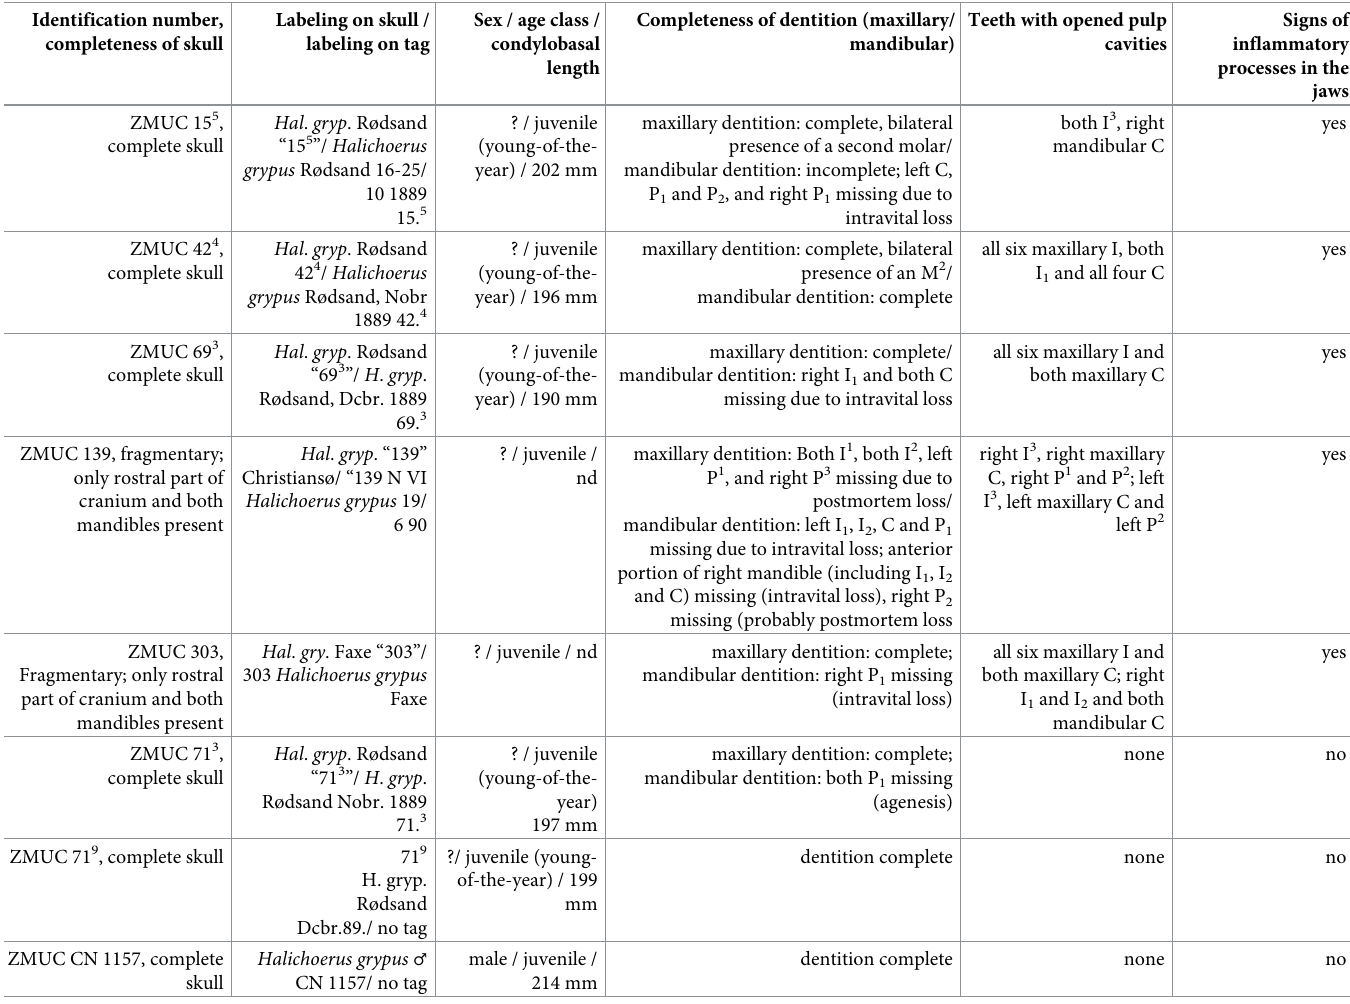
Table 1. List of Baltic grey seals ( Halichoerus grypus grypus ) skulls from the collection of the Natural History Museum of Denmark, University of Copenhagen (ZMUC) analyzed in the present study. All teeth present in the specimens belonged to the permanent dentition, and no persistent deciduous teeth were recorded. The labeling is given as it appears on the skulls and the tags (Nobr = November, Dcbr =